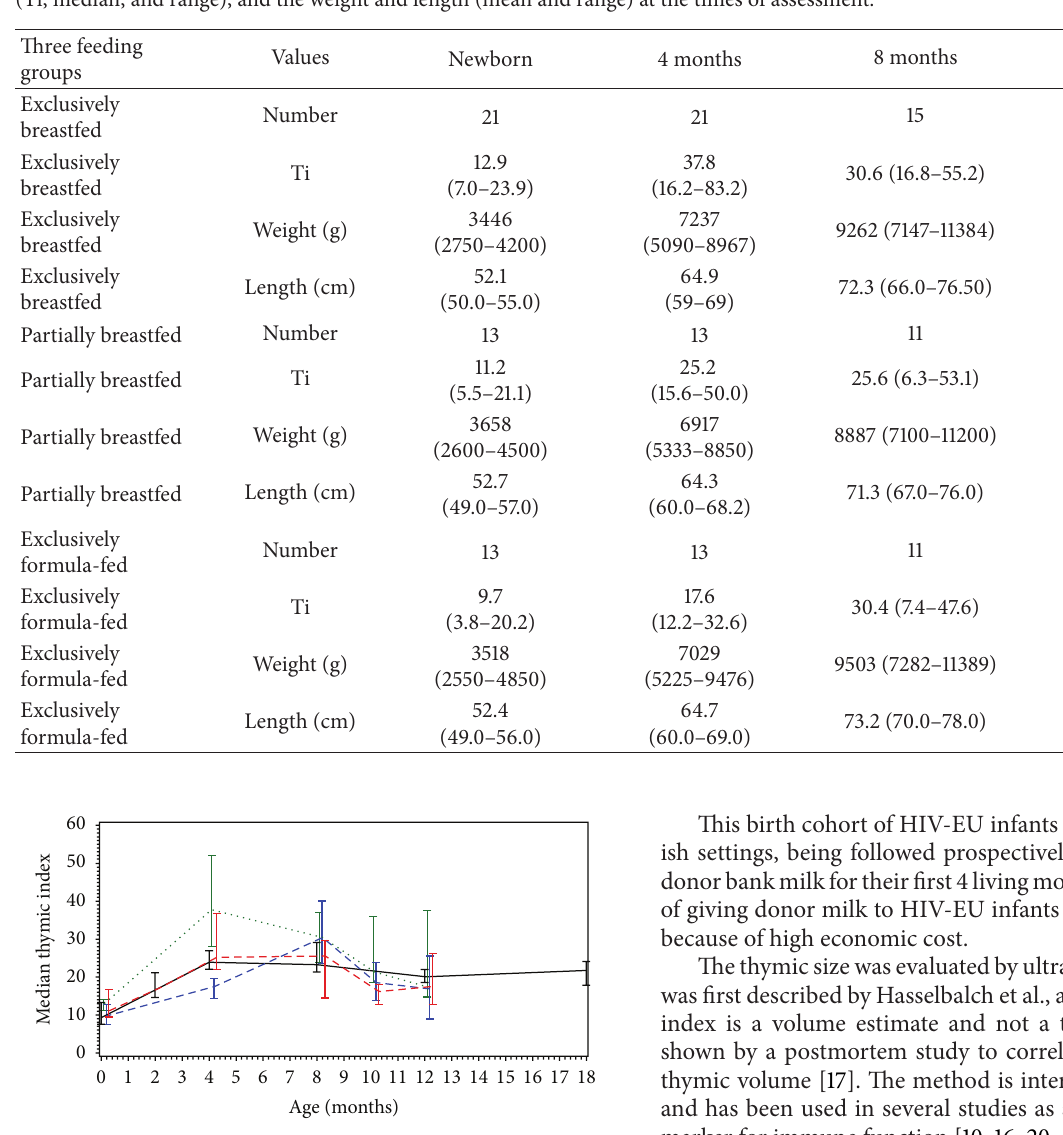
Table 3: The term HIV-unexposed infants divided into the three feeding groups at 4 months of age: the number of infants, the thymic size (Ti, median, and range), and the weight and length (mean and range) at the times of assessment.